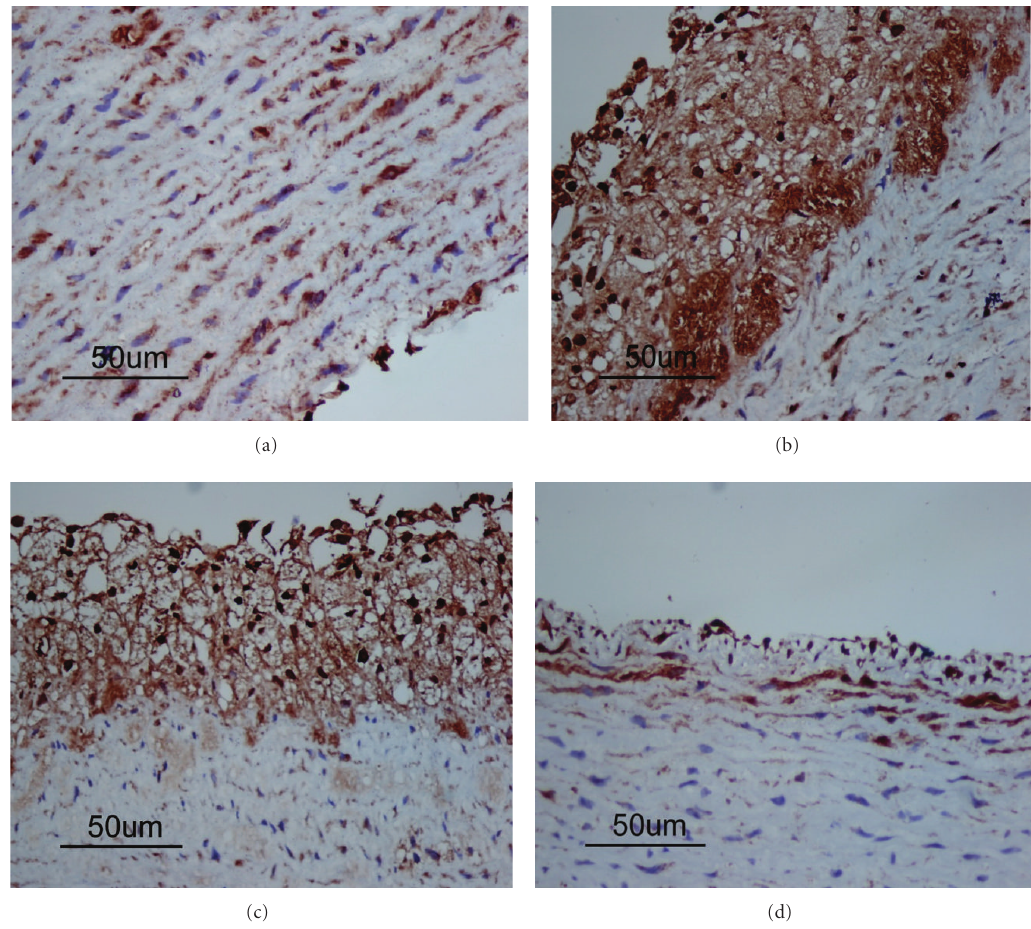
Figure 5: CD62-P expressions in atherosclerotic lesion from di ff erent groups with immunohistochemistry. Representative photographs of immunohistochemistry from di ff erent groups are shown. Positive CD62-P expression is shown in brown. In the control group (a), the expression of CD62-P in the intima was minimum. In the HFD group (b), there was significantly increased CD62-P expression in the intima. In the rosuvastatin group (c), there was less but considerable CD62-P expression in the intima. Compared to the HFD group, there was significantly reduced CD62-P expression in the intima from atRA group (d) (magnification ×